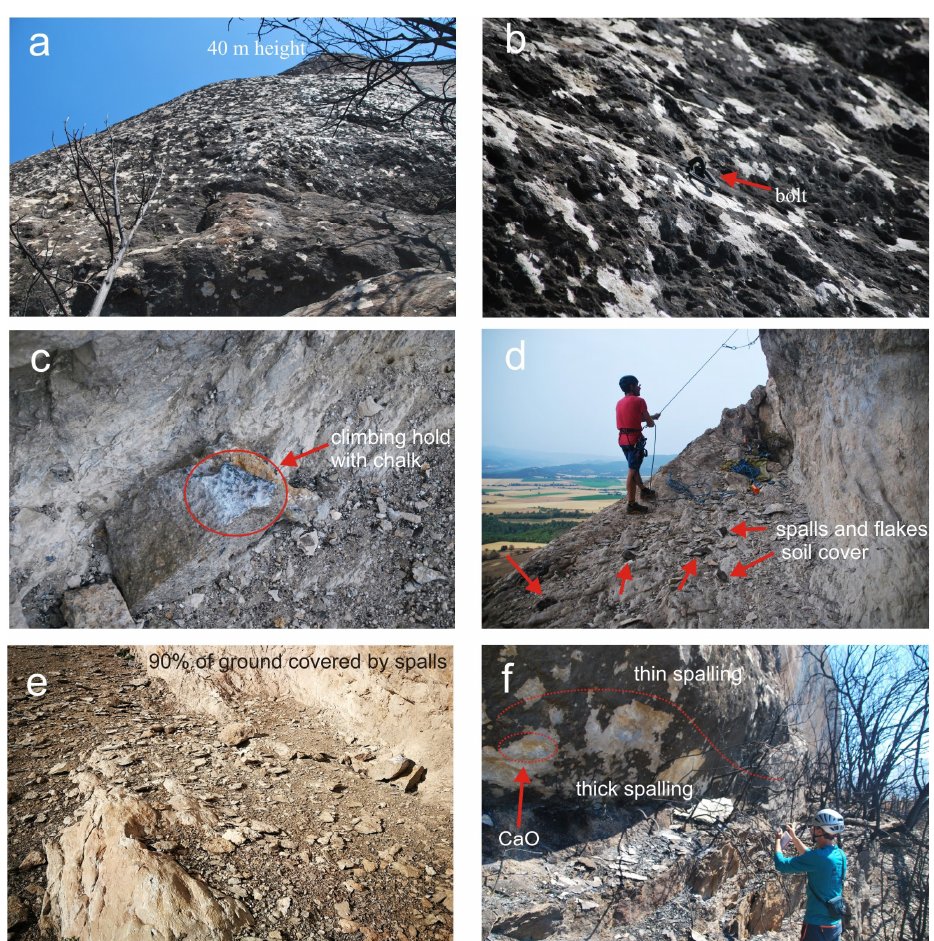
Figure 7. Visible rock surface decay features in Oliana as a result of the fire: ( a ) flaking and spalling on the left side of the climbing crag; ( b ) extensive flaking affecting an anchor; ( c ) large rockfall from a climbing route (notice that the rock still preserves the climbing chalk); ( d ) climbing area covered by spalled flakes; ( e ) ground of climbing area is 90% covered by spalls (photograph: Toni Mas); ( f ) limit of thick and thin spalling due to prolonged heat in the lower part provided by adjacent burned